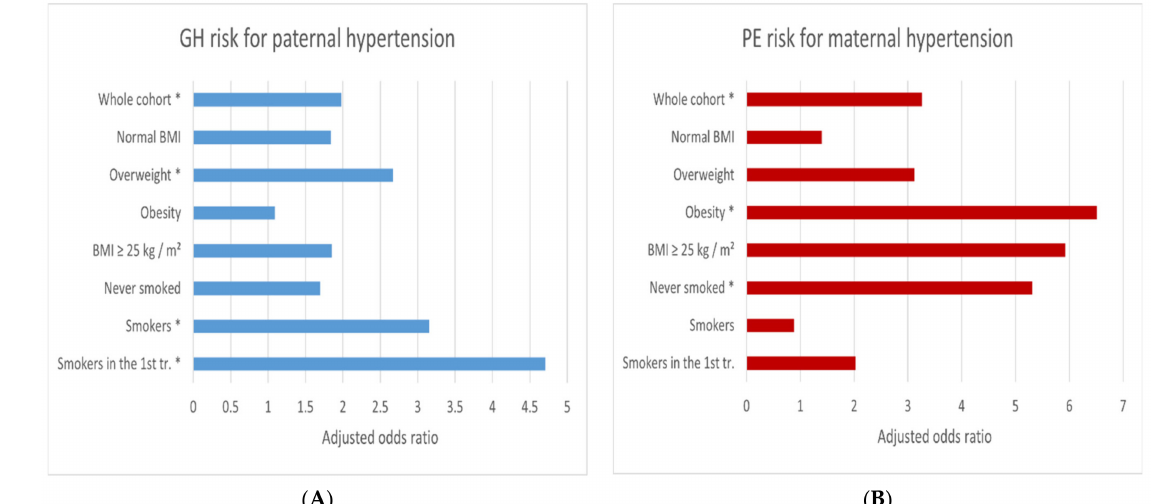
Figure 1. The adjusted odds ratios of gestational hypertension (GH) ( A ) and preeclampsia (PE) ( B ) for hypertension in the parents (vs. ‘Absence of hypertension in the family’) in the whole cohort and subgroups. The results were calculated in multiple logistic regression after adjusting for maternal age, pre-pregnancy body mass index (BMI), primiparity, gestational weight gain (GWG) out of the range and smoking in the first trimester (AOR-a). * Statistically significant results (Table